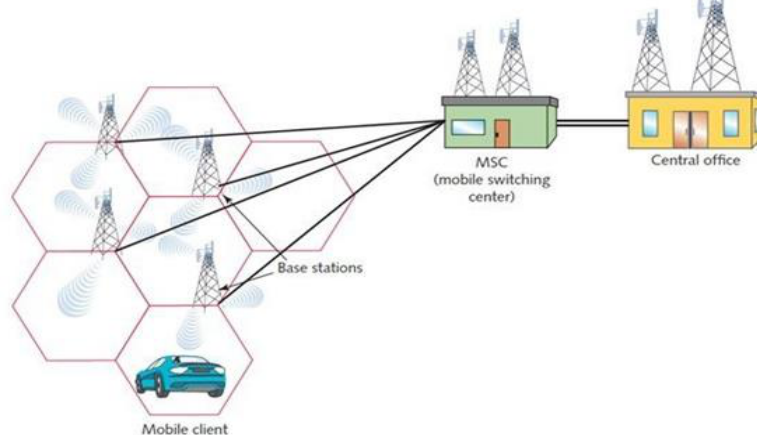
Fig. 1. Design and arrangement of the coverage radii of telecommunication